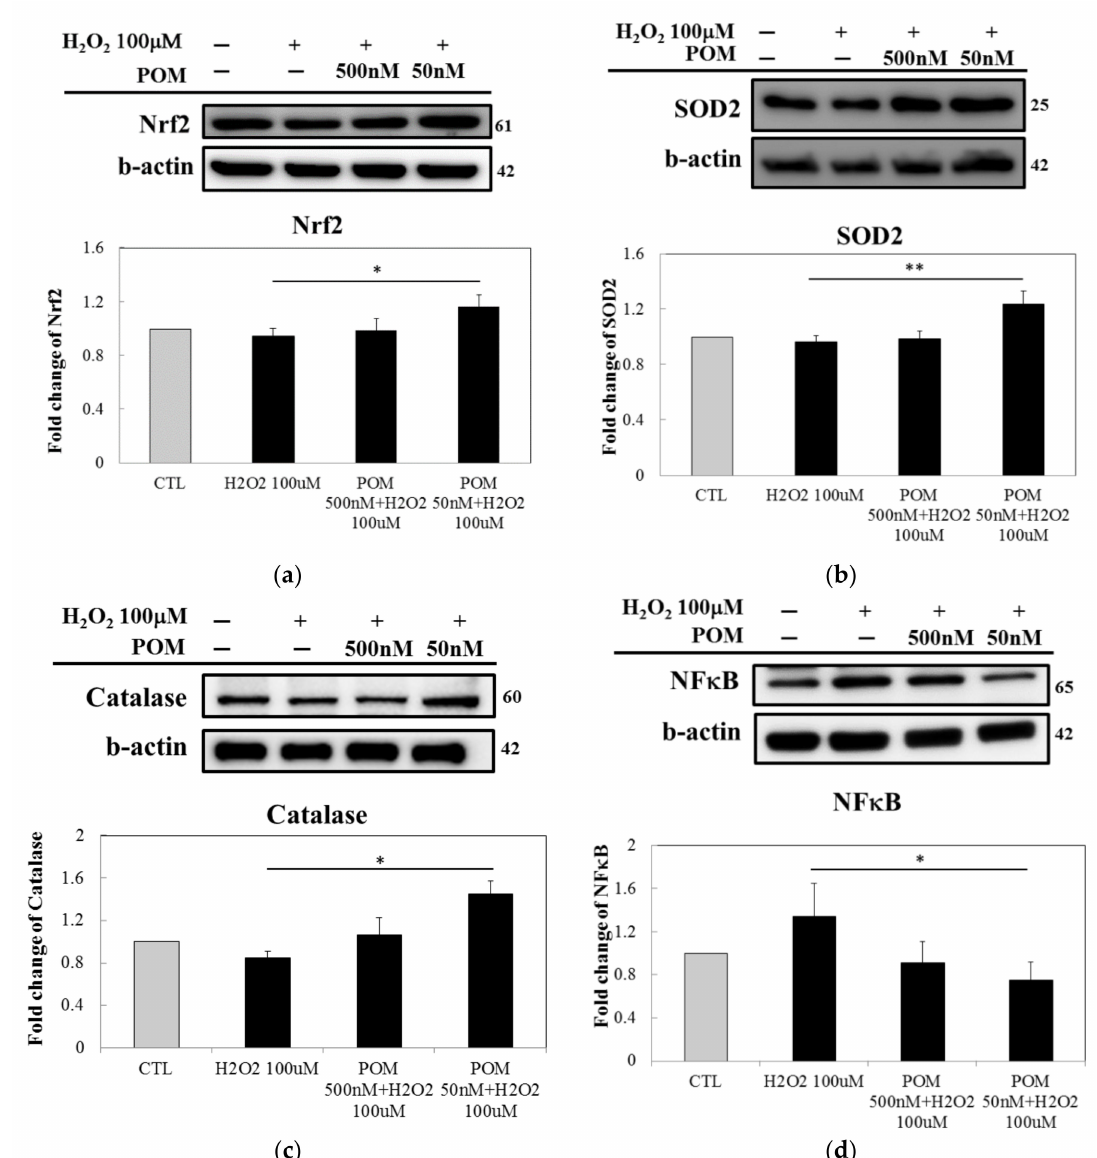
Figure 4. Pomalidomide (POM) activates Nrf2, which involves antioxidant enzymes SOD2 and Catalase and decreases NF- κ B that is known in many cell types as a sensor for oxidative stress. In relation to the expression of antioxidant enzymes, there was no significant difference between the control (CTL) group and H 2 O 2 alone challenged group. Notably, however, POM-pretreatment (50 nM) significantly enhanced the generation of antioxidant enzymes. As to H 2 O 2 -induced actions on the levels of NF- κ B, whereas H 2 O 2 alone mildly elevated NF- κ B levels, POM-pretreatment (50 nM) markedly reduced NF- κ B. Protein levels of Nrf2 ( a ), SOD2 ( b ), Catalase ( c ) and NF- κ B ( d ) in primary rat cortical neurons were measured by Western blot analysis. β -actin served as a control. Bars represent mean values ± standard error of the mean ( n = 3). * p < 0.05, ** p < 0.01 versus 100 µ M H 2 O 2 -alone challenged group. NF- κ B, nuclear factor kappa-light-chain-enhancer; Nrf2, nuclear factor erythroid derived 2; SOD2, superoxide dismutase